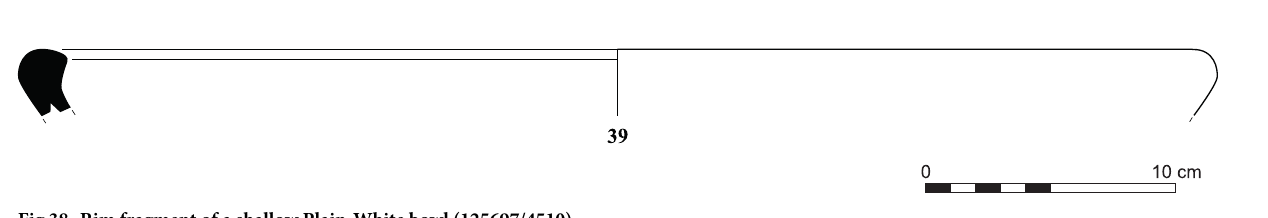
Fig 37. Rim fragment of a shallow Plain-White bowl (125693/4510).